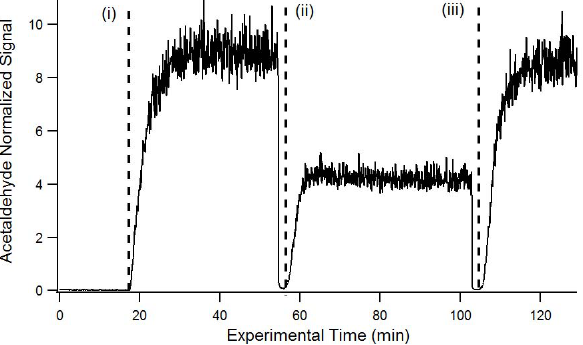
Fig. 5. Sample time series of signal due to gas-phase acetaldehyde in the PTR-MS experiment. The acetaldehyde signal normalized to the reagent ion is shown as a function of time. Time (i): 25mL of clean water in the bubbler is replaced by 25mL of acetaldehyde solution (10mM); Time (ii): 13.3mM of H 2 O 2 is added to the ac- etaldehyde solution; Time (iii): one drop of catalase stock solution is